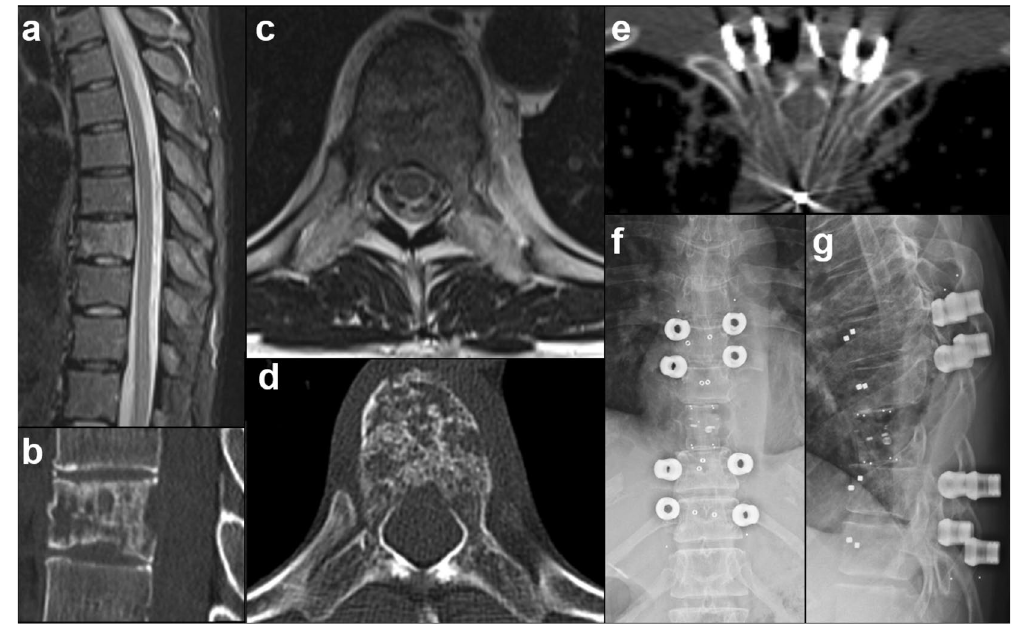
Figure 2. Case example of a 48-year-old female suffering from metastatic breast cancer with a singular metastasis at Th8 (SINS 7, preop. images a–d ). The patient suffered from isolated thoracic back pain without neurological deficits and a KPS of 90%. She was treated by en-bloc spondylectomy of Th8 with CFRP vertebral body replacement and iCT-based navigated posterior instrumentation from Th6 to Th10 using CFRP pedicle screws (intraop. imaging e and postop. X-ray f + g ). Adjuvant stereotactic radiosurgery was performed using CyberKnife.